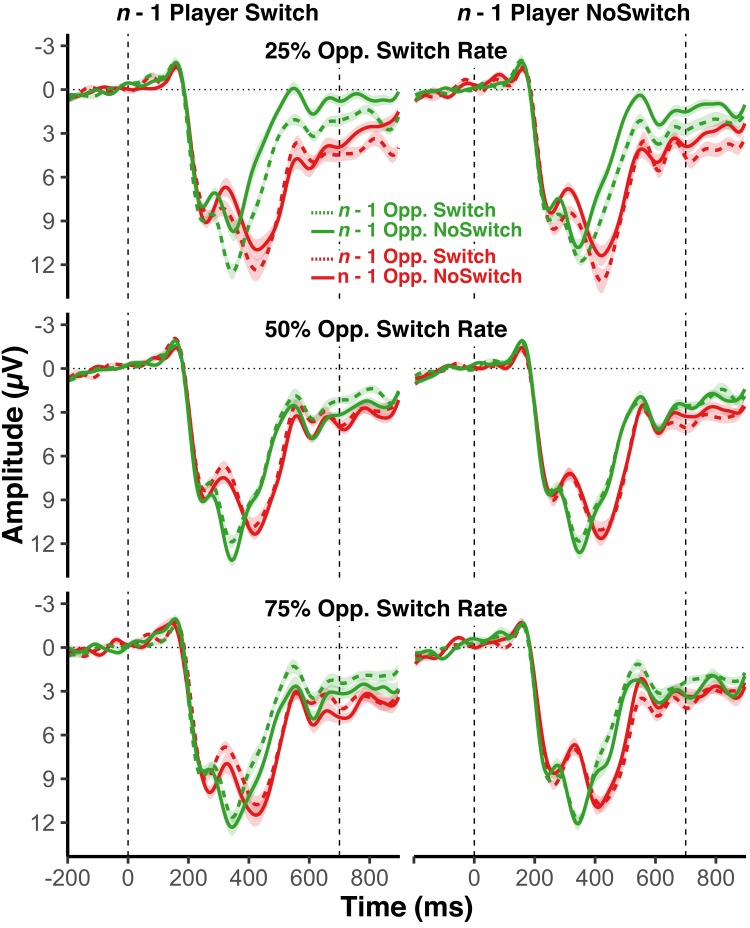
Event-related potentials.The supplement shows event related potentials (ERPs) in terms of grand average EEG activity for electrodes Fz and Cz grouped by all factors used in the EEG analysis: the opponent’s overall switch rate (20,50,75%), the n-1 opponent switch/no-switch choice, and the n-1 player’s switch/no-switch choice. The EEG signal was low-pass filtered (Butterworth, 25 Hz), time-locked to the onset of feedback, and subtracted from the average across the 200 ms baseline period prior to the feedback signal. The shaded area indicates within-subject 95% confidence intervals around the average signal. Following the feedback (200 to 300 ms after the onset), we observed a typical feedback-related negativity (FRN), with a peak that was more negative for loss feedback compared to win feedback. Consistent with the results of the main analysis, the FRN was affected by the combination of feedback and context variables: The FRN amplitude was most negative for unexpected opponent switch or repeat choices, that is for opponent switch choices for 25% switch-rate opponents and (to a lesser degree) for repeat choices when facing 75% switch-rate opponents). The fact that we generally find a larger negativity during the typical FRN time range (200 to 300 ms after the onset of feedback) following loss trials is consistent with a negative prediction error account.